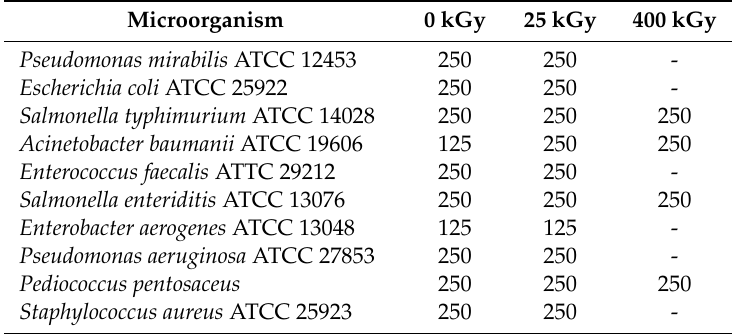
Table 3. MIC values (mg · L − 1 ) of non-irradiated and irradiated ertapenem samples.